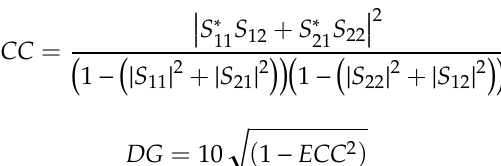
Figure 8. Surface current distribution without ( left side ) and with ( right side ) corrugated t-shape parasitic element at ( a ) at 5 GHz ( b ) 10 GHz and ( c ) 15 GHz.